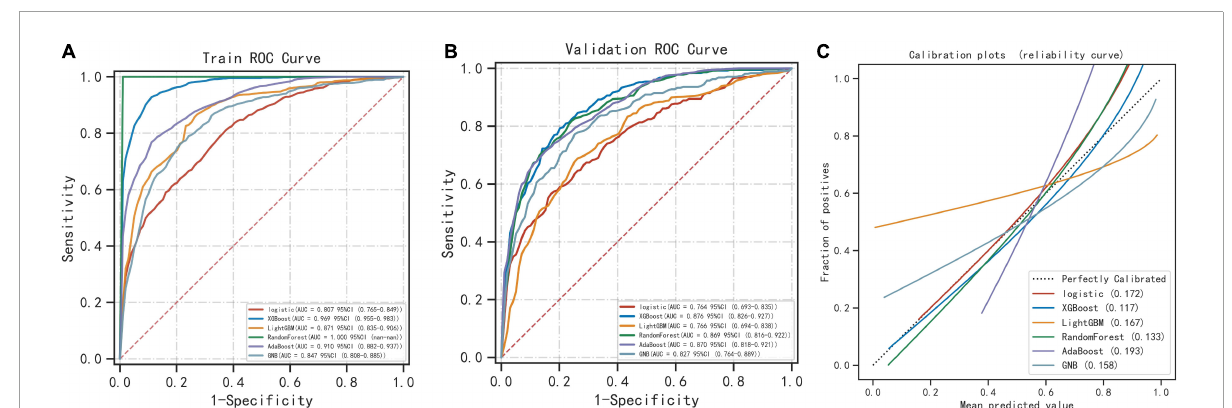
FIGURE2 Comparison of 6 machine learning algorithms. (A) The ROC results of the models established by 6 machine learning algorithms in the training set. (B) The ROC results of the models established by 6 machine learning algorithms in the validation set. (C) Calibration plots of models built by 6 machine learning